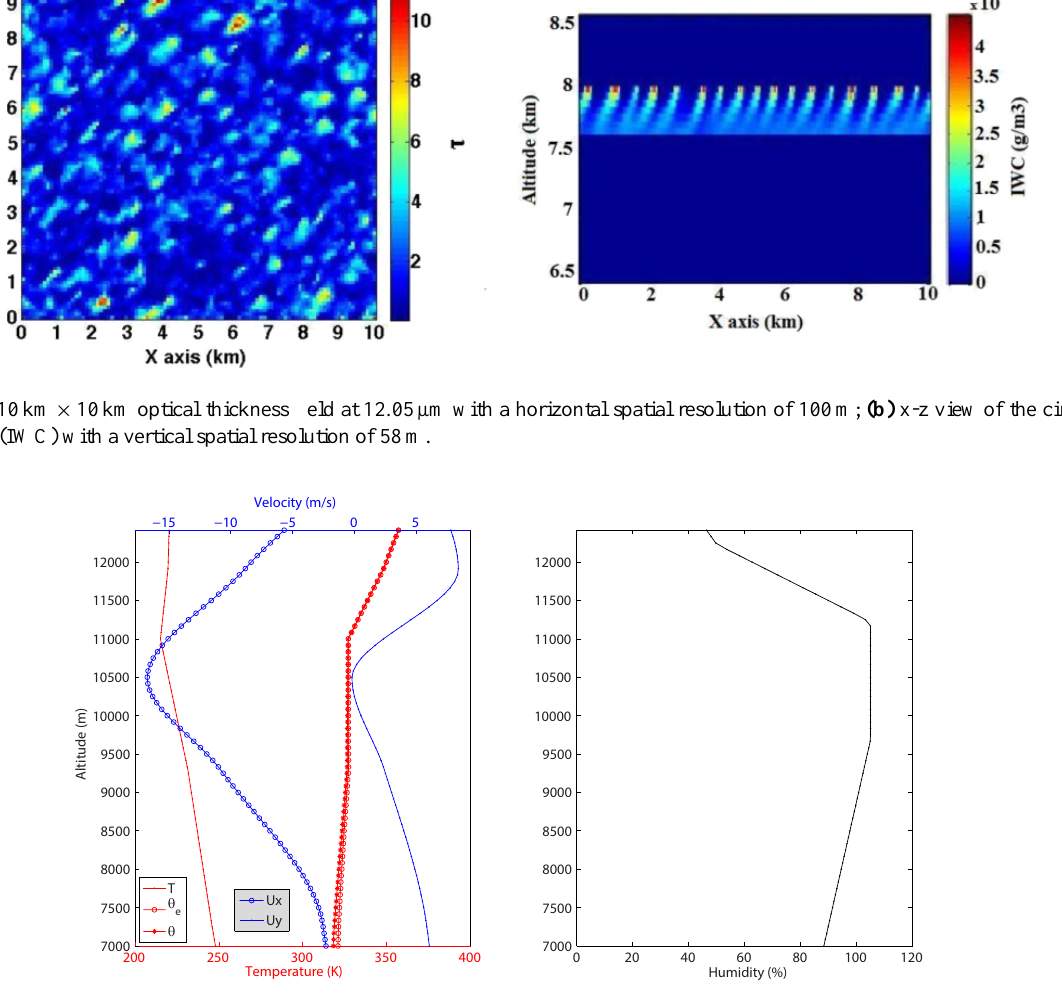
Figure 2. Basic state thermodynamic and moisture structure initially specified for cirrus CII-1 (with T being the thermodynamic temperature, θ the potential temperature, θ e the equivalent potential temperature and Ux and Uy the wind profile on the x and y axes, respectively) and the relative humidity